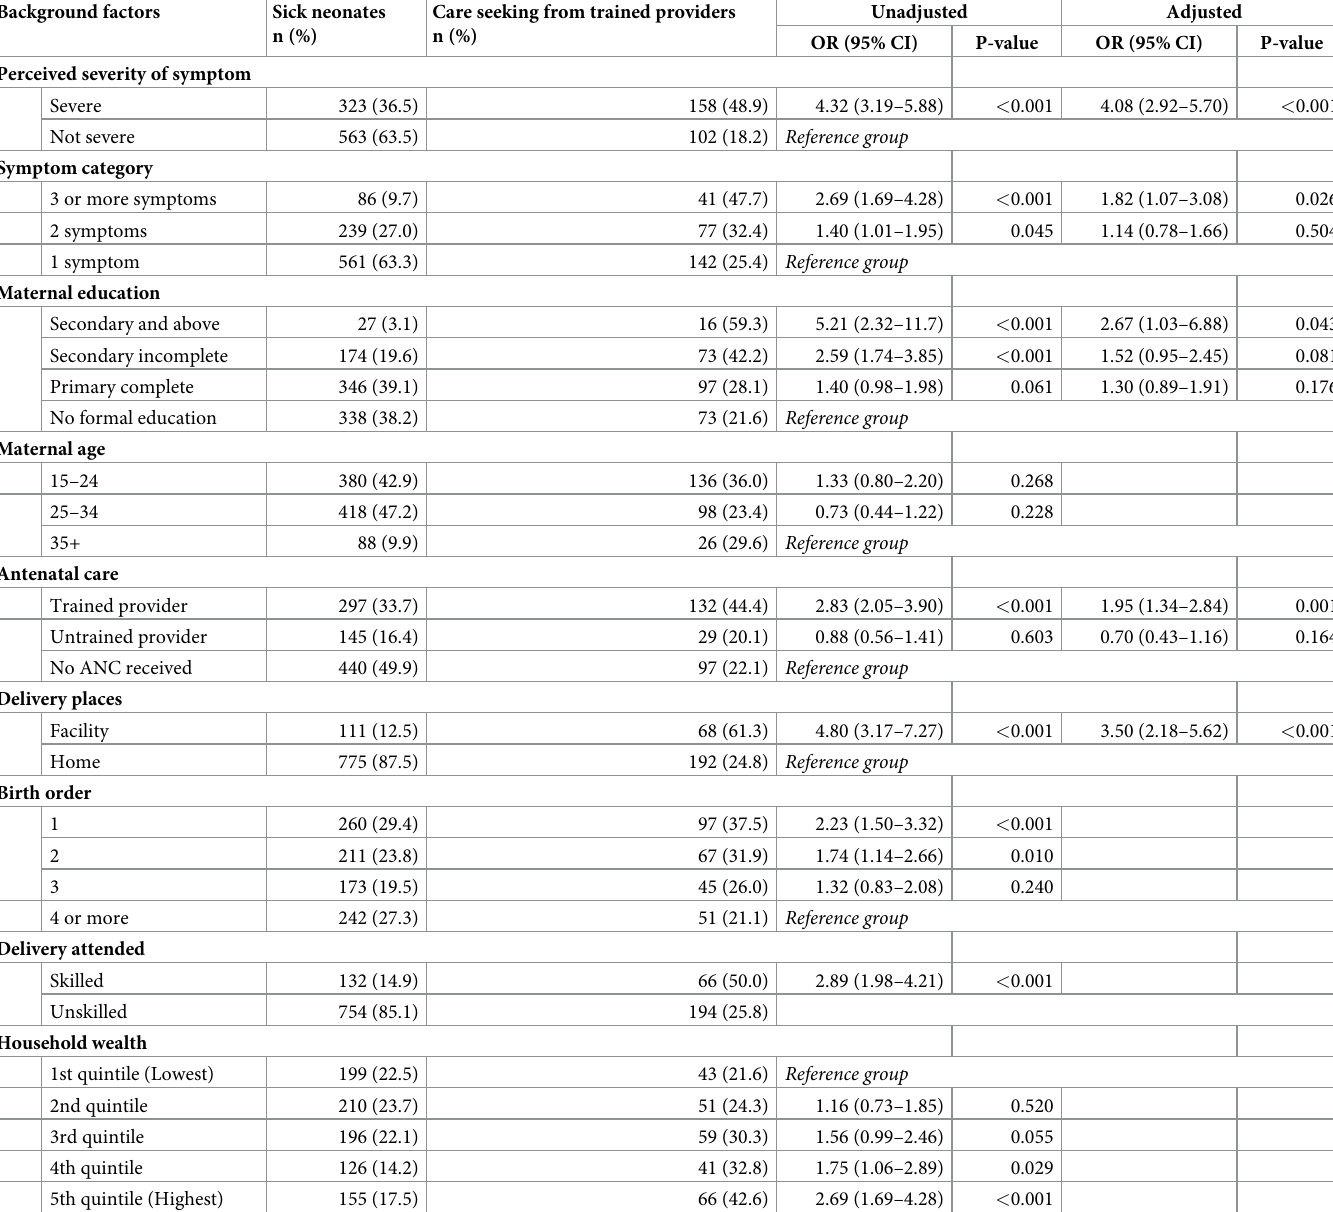
Table 3. Factors associated with care-seeking for sick neonates from trained providers (N =